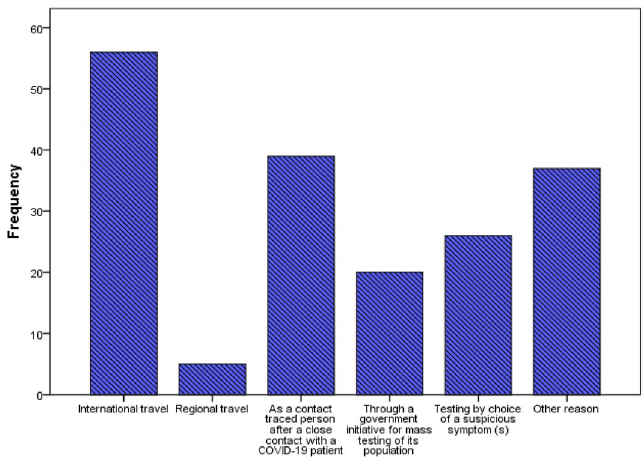
Figure 3. This figure represents an analysis of the reasons cited by participants for being screened for COVID- 19 disease by